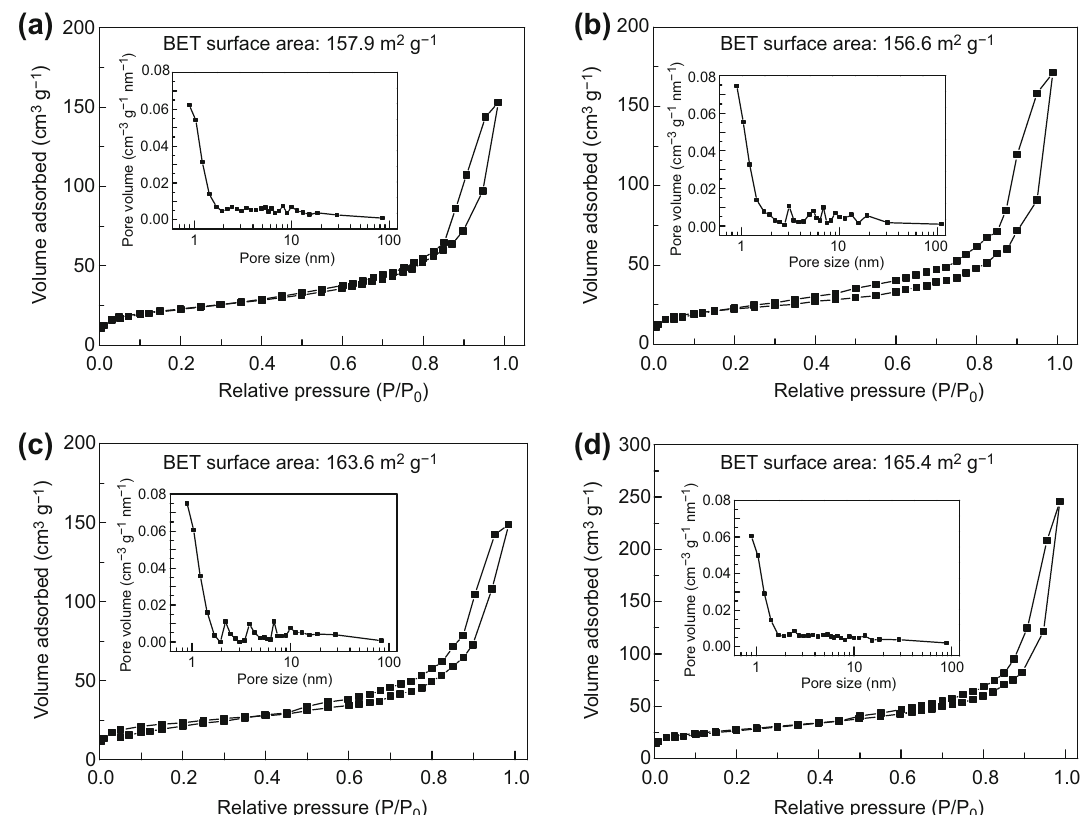
Fig. 4 The nitrogen adsorption/desorption curves and pore size distribution curves of a BC, b BC/GO-1, c BC/GO-2, and d